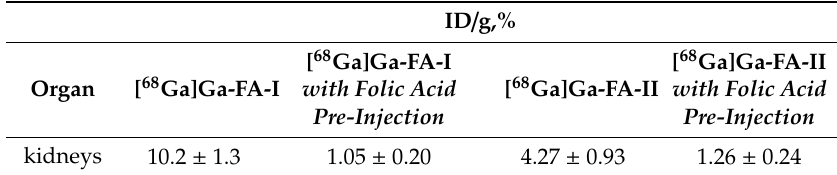
* other organs and tissues data are omitted for clarity due to low accumulation similar to that presented in Table 1.